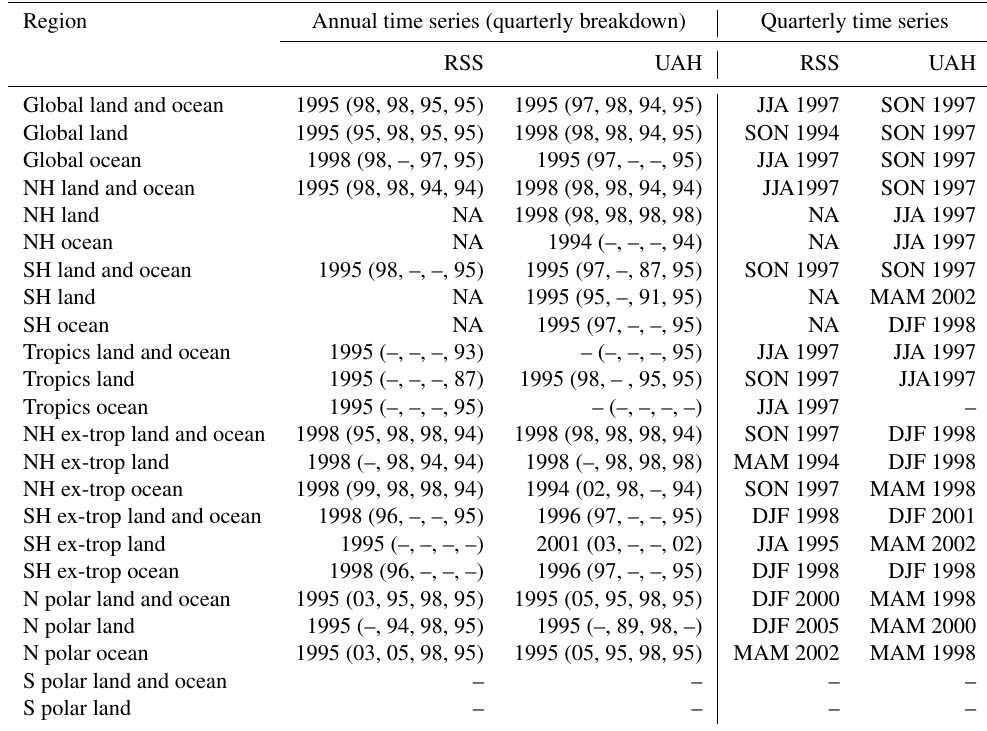
Figure 4. Quarterly mean lower tropospheric satellite (RSS, UAH) and surface (HadCRU, GISS) temperature anomalies on a common baseline 1979–2014. Annual anomalies (dotted lines) and internal trends (dashed lines) are separated by step changes. Table 1. Dates of step changes for lower tropospheric satellite temperature anomalies, with annual time series and quarterly breakdowns in parentheses (DJF, MAM, JJA, SON), and quarterly time series. Data sources include remote sensing systems (RSS) and the University of Alabama, Huntsville